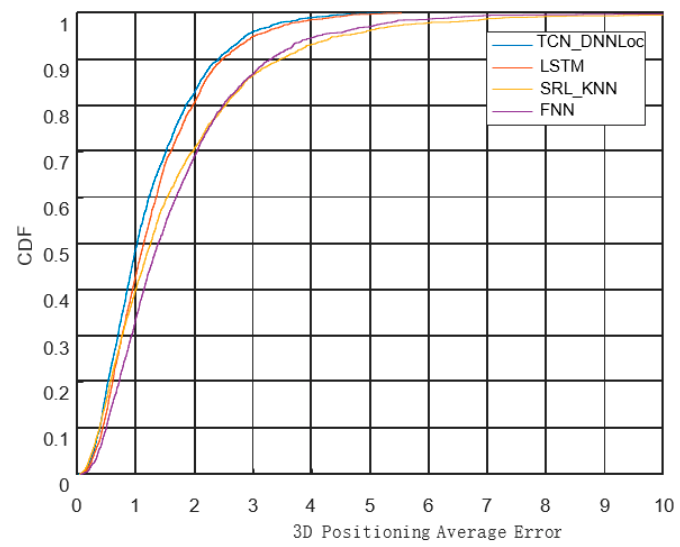
Figure 14. Cumulative distribution functions for different models.